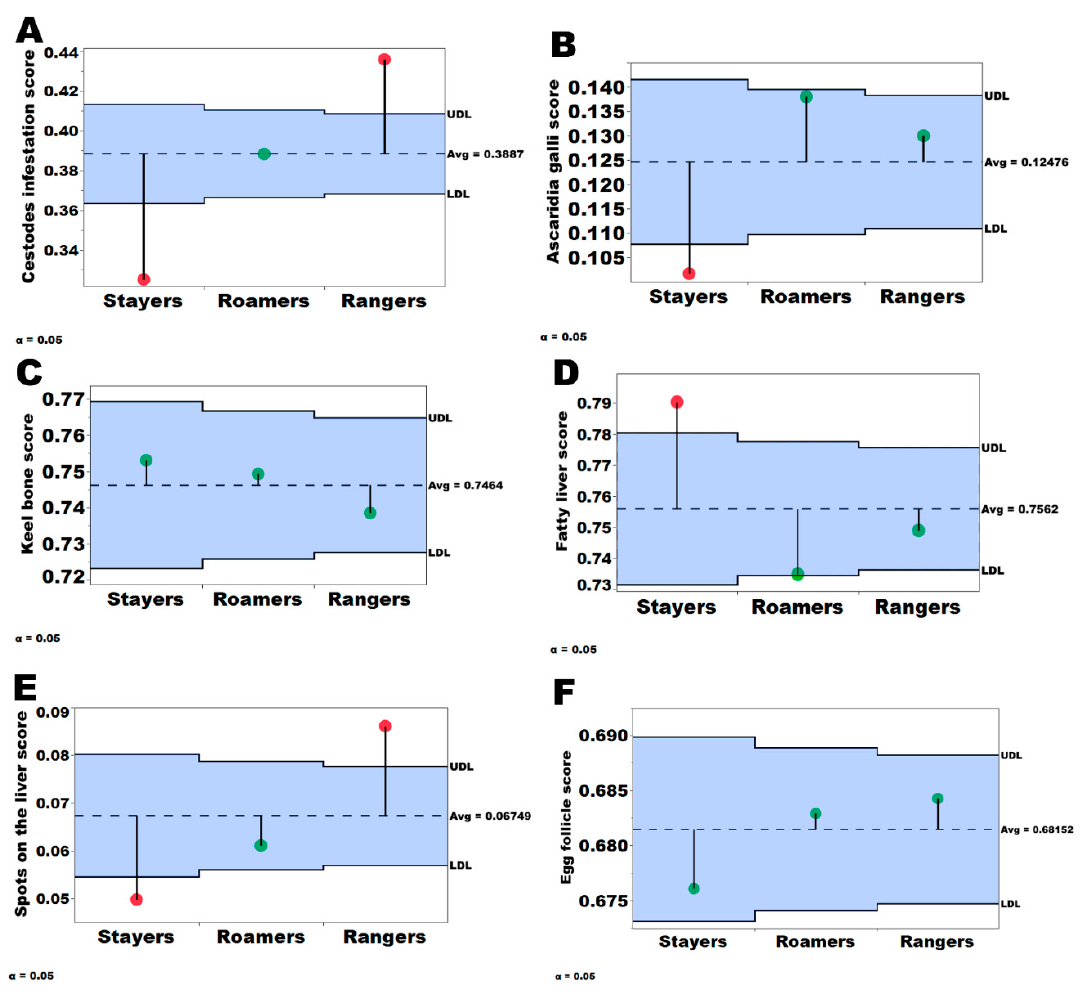
Figure 2. Analysis of means for proportions for A. galli ( A ), cestodes ( B ), keel bone ( C ), fatty liver ( D ), spots on the liver ( E ) and egg follicle condition score ( F ). The solid black lines indicate the upper decision line (UDL) and the lower decision line (LDL) at the 95% confidence level. The dashed black line represent the population mean score. The red dots at the end of the needle indicate a significant difference ( p < 0.05) from the population mean, while the green dots at the end of the needle indicate no statistical significance.